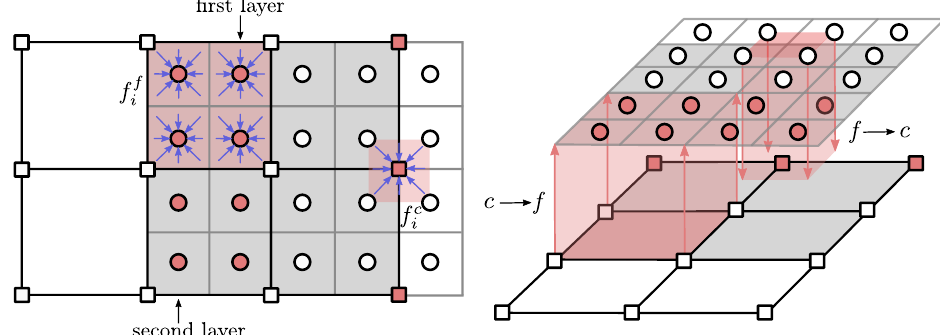
Figure 6. Grid transition interface for two-dimensional combined grid layout, : Regular fine node, : Fine interface node, : Regular coarse node, : Coarse interface node, light-red area indicates validity range of interpolation functions, inward pointing arrows represent pre-collision distribution functions reconstructed on both grids during c → f and f → c coupling according to Equations (60) and (61),